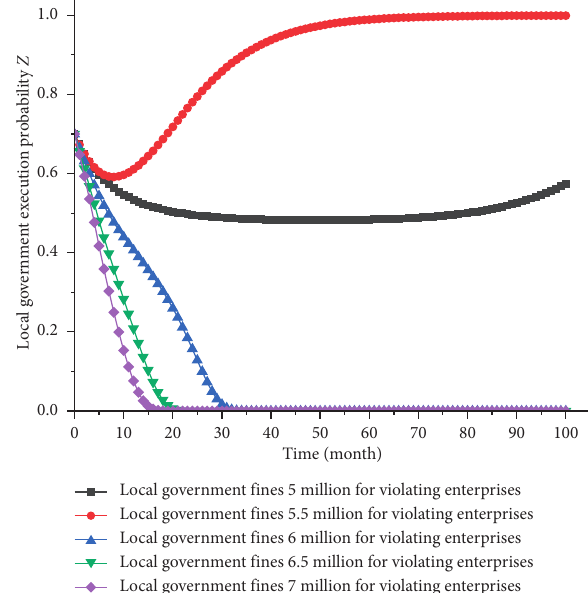
Figure 17: The impact of local fines on local government strategy choices.